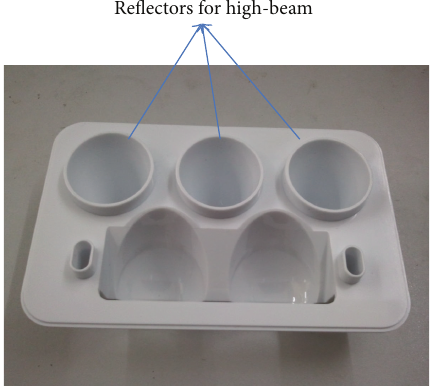
Figure 10: Mold of the designed headlamp.